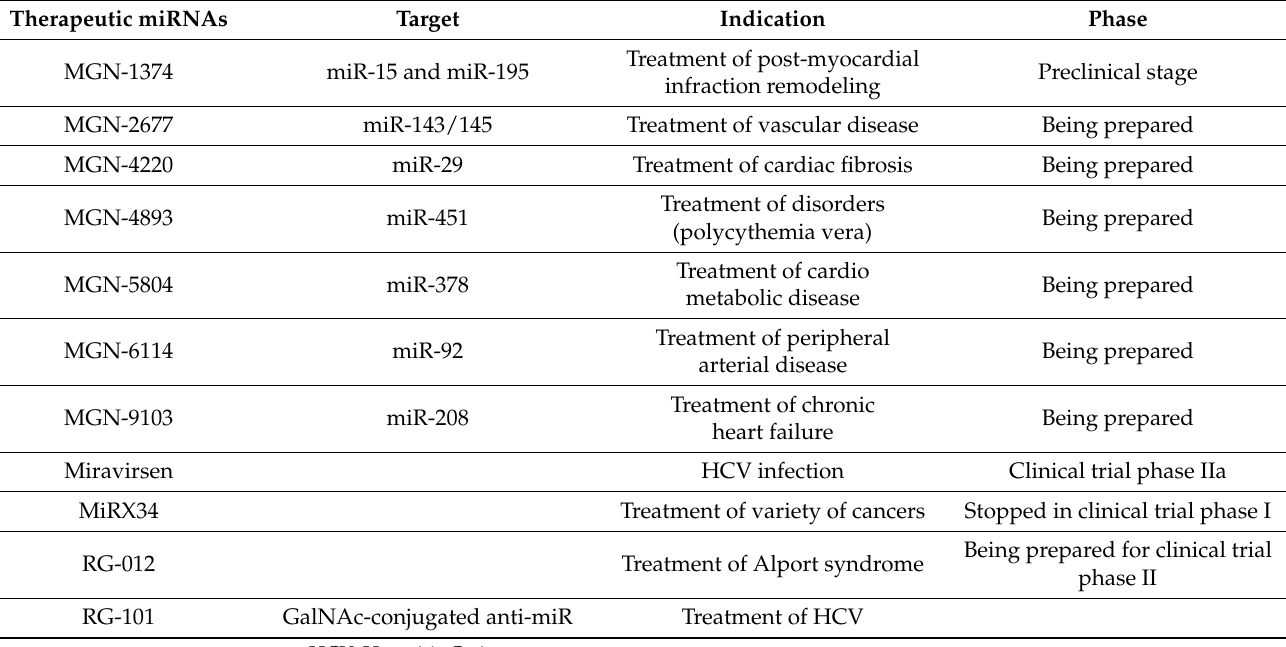
Table 9. Therapeutics miRNAs that are in a development phase, and their indication